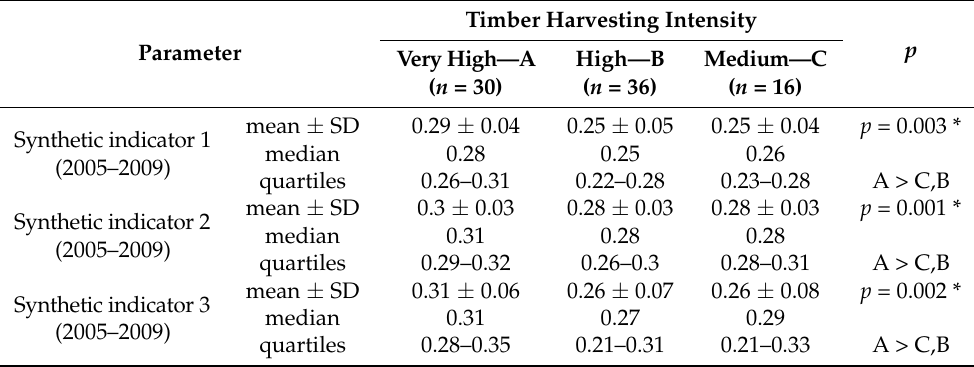
Table 7. Relationships between the synthetic indicators and forest district categories distinguished on the basis of timber harvesting intensity.